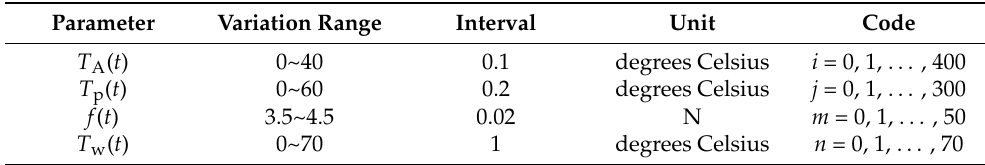
Table 1. Divided and numbered T A ( t ), T p ( t ), f ( t ), and T w ( t ). Parameter